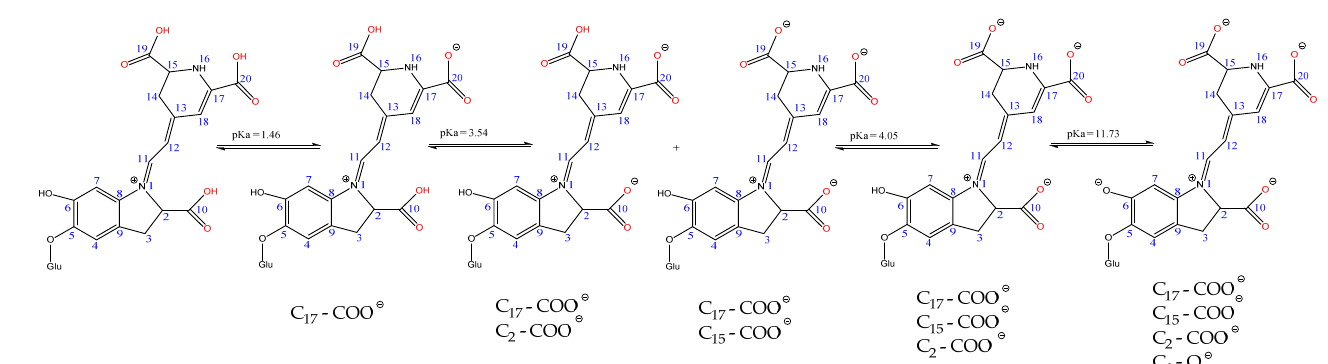
C17, C17 + C2, C17 + C15, C17 + C15 + C2, and C17 + C15 + C2 + OH6. The degree of Figure 9. Deprotonation of carboxylic groups in betanin depending on the pKa value.